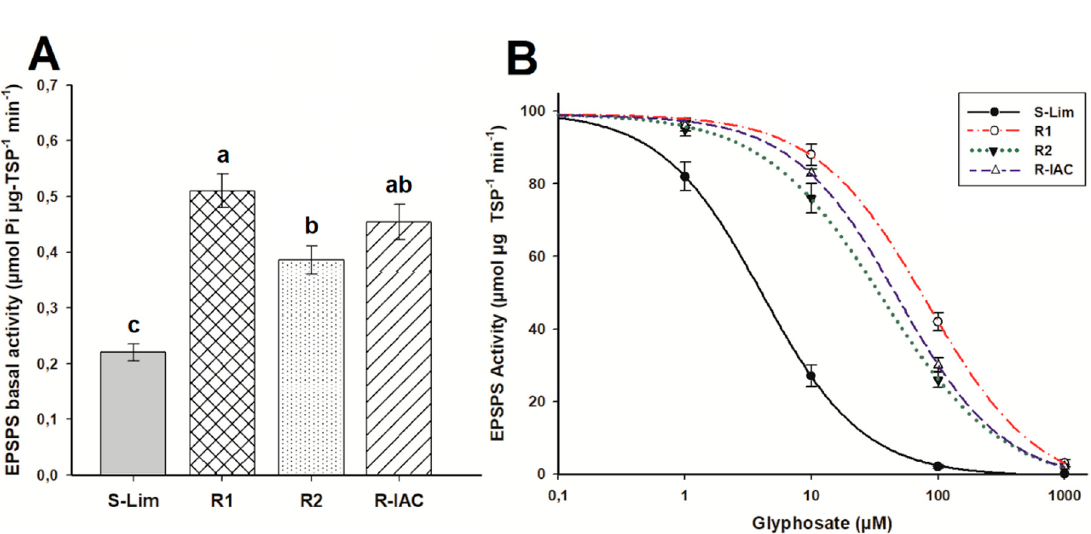
Figure 3. EPSPS (5-enolpyruvylshikimate-3-phosphate synthase) activity in glyphosate-susceptible and -resistant slender amaranth ( Amaranthus viridis L.) populations collected in citrus orchards from S ã o Paulo State, Brazil a. ( A ) Basal EPSPS activity (absence of glyphosate). Same letter above bars are not di ff erent using the Tukey test at 95%. ( B ) Dose-response curves of the EPSPS enzyme activity, expressed as a percentage of the untreated control, exposed to di ff erent glyphosate concentrations ( µ M). Histograms represent the means, and vertical bars the standard error ( n =